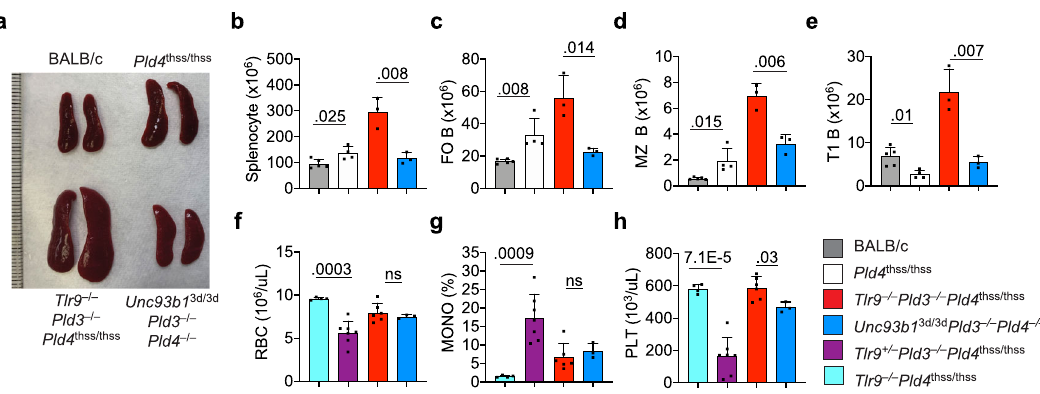
Fig. 2 Splenomegaly and increased B cell numbers in Tlr9 − / − Pld3 − / − Pld4 thss/thss mice on the BALB/c background compared to Unc93b1 3d/3d Pld3 − / − Pld4 − / − mice. Mice of the indicated genotypes were compared for a , b splenomegaly, c splenic follicular B cells, d splenic MZ B cells, e splenic transitional-1 (T1) B cells, f blood erythrocytes, g blood monocytes, h platelets. Each data point indicates the value obtained with an independent mouse, bars show mean ± SD. In b – e , mouse groups were BALB/c ( n = 5), Pld4 thss/thss ( n = 4), Tlr9 − / − Pld3 − / − Pld4 thss/thss ( n = 3), and Unc93b1 3d/3d Pld3 − / − Pld4 − / − ( n = 3). In f – h , mouse strains compared were Tlr9 − / − Pld4 thss/thss ( n = 4), Tlr9 − / − Pld3 − / − Pld4 thss/thss (7), Unc93b1 3d/3d Pld3 − / − Pld4 − / − ( n = 3), and Tlr9 + / – Pld3 − / − Pld4 thss/thss ( n = 7). Statistical test was two-tailed T Test of the indicated pairwise group comparisons. Experiment was carried out